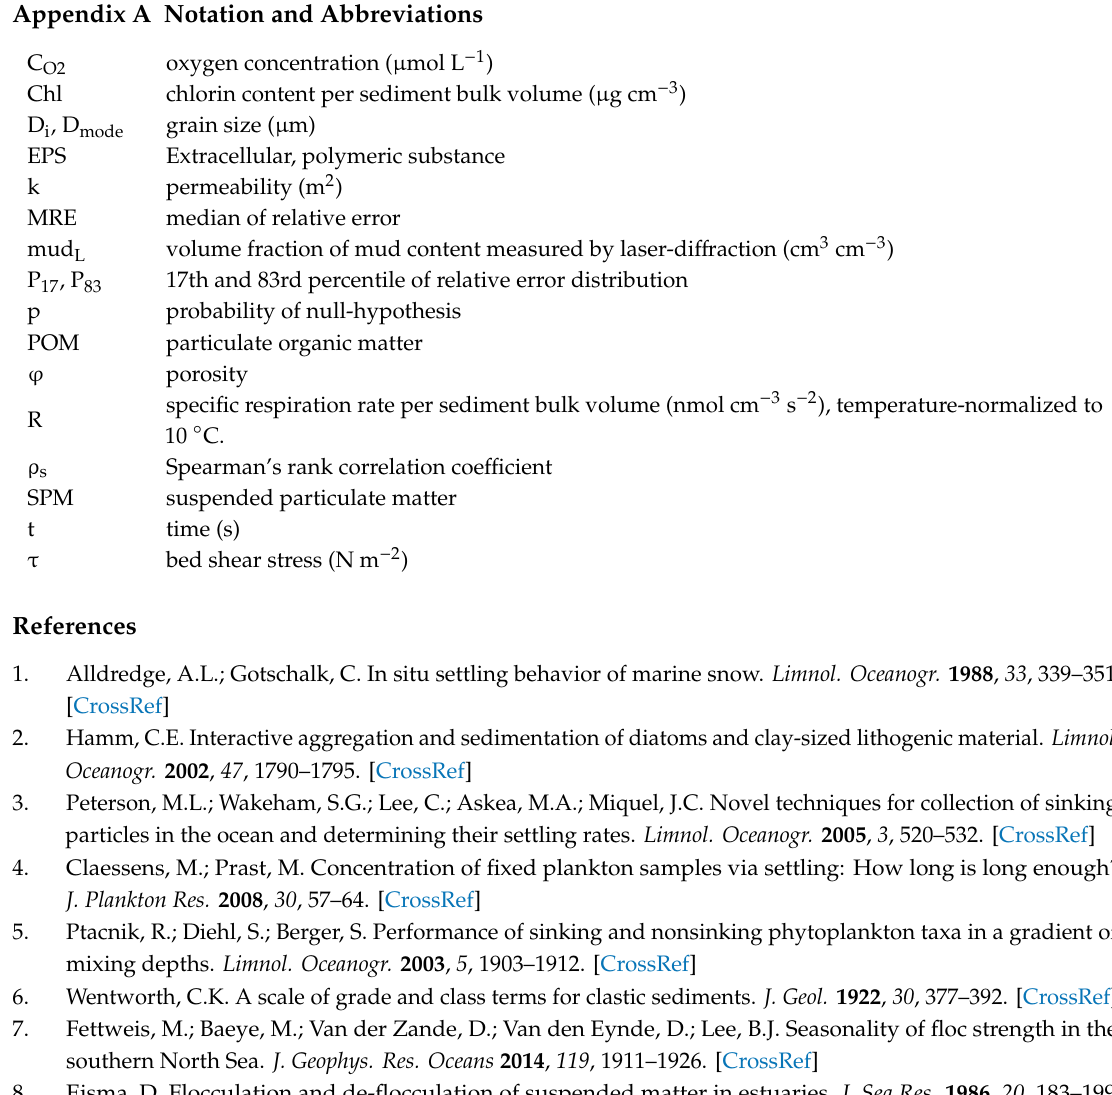
Table S1: Data supplemental for Neumann et al. Ballasted flocs capture pelagic primary production and alter the local sediment characteristics in the coastal German Bight (North